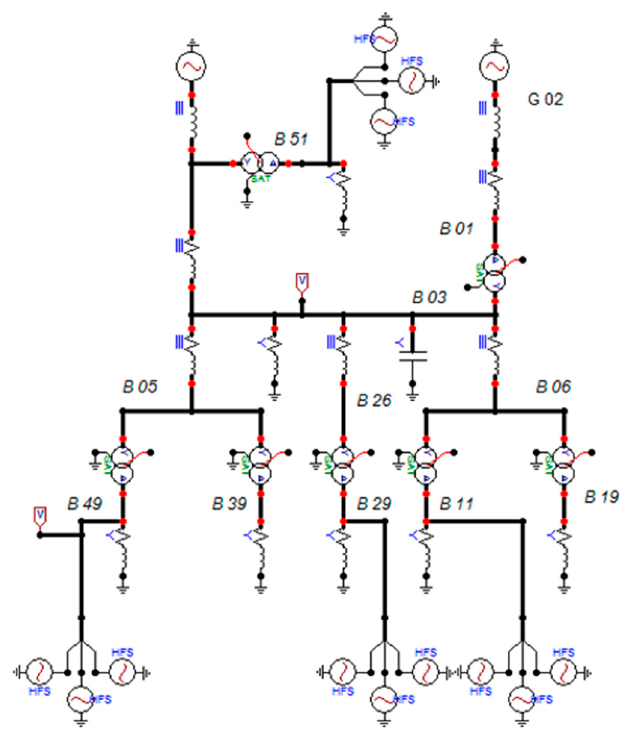
Figure 3. IEEE-13 bus industrial electrical distribution system as used in [10].